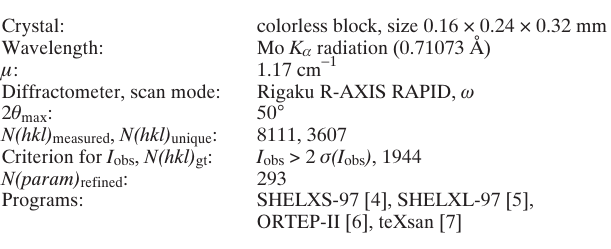
Table 1. Data collection and handling.